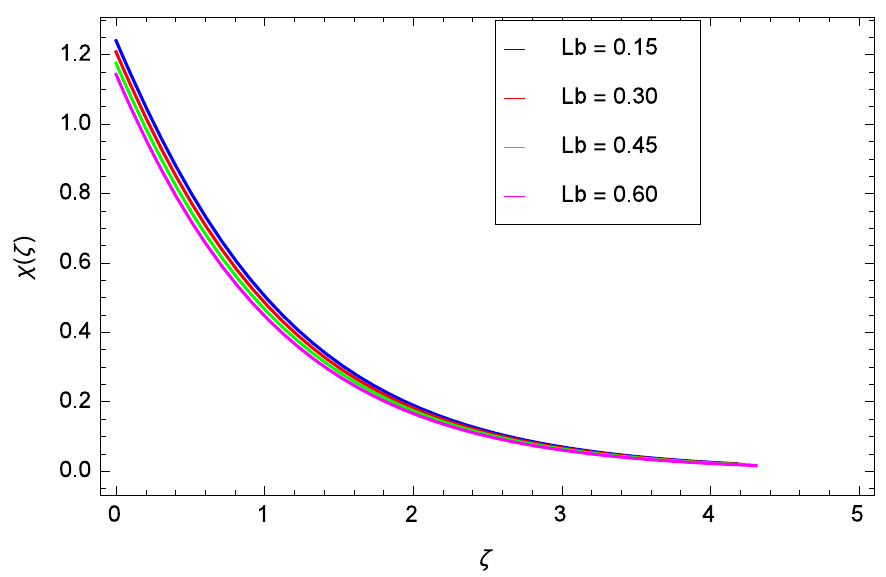
Figure 22. Influence of Lb on χ ( ζ )